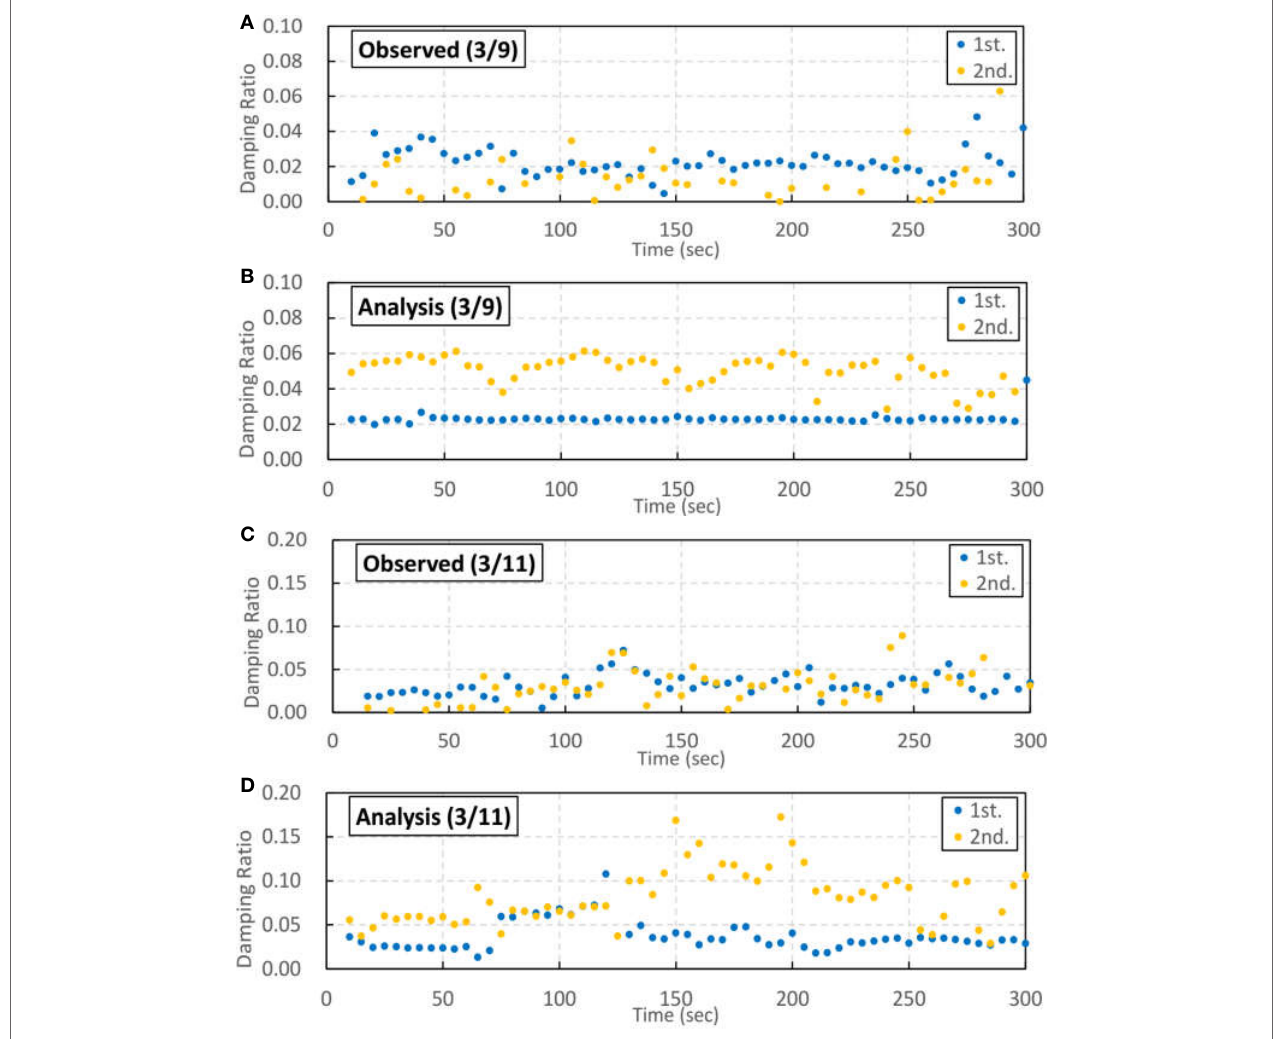
FigUre 14 | Auto-regressive exogenous analysis results for damping ratio in the N–S direction: (a) change in first and second damping ratios during the 3/9 pre-shock for observed results only, (B) that of analytical result only, (c) that during the 3/11 main shock for observed results only, and (D) that of analytical result